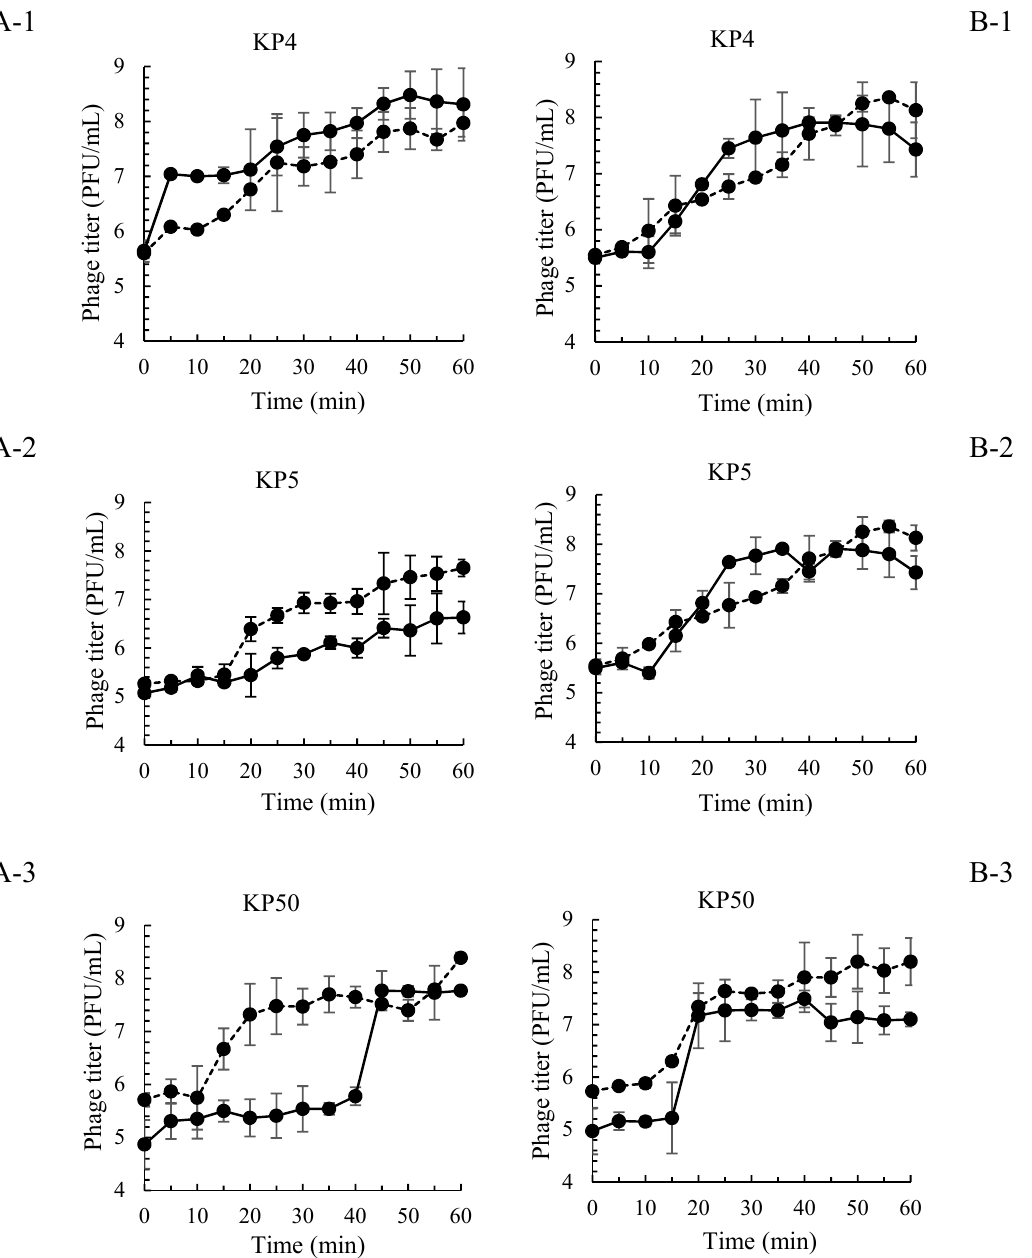
Figure 2. One-step growth curve of phage KP4, KP5 and KP50 on S. Enteritidis ( A-1 , A-2 and A-3 ) and S. Typhimurium ( B-1 , B-2 and B-3 ). MOI 100 presented by and MOI 10 presented by . Bars represent the mean standard deviation ( n = 3).